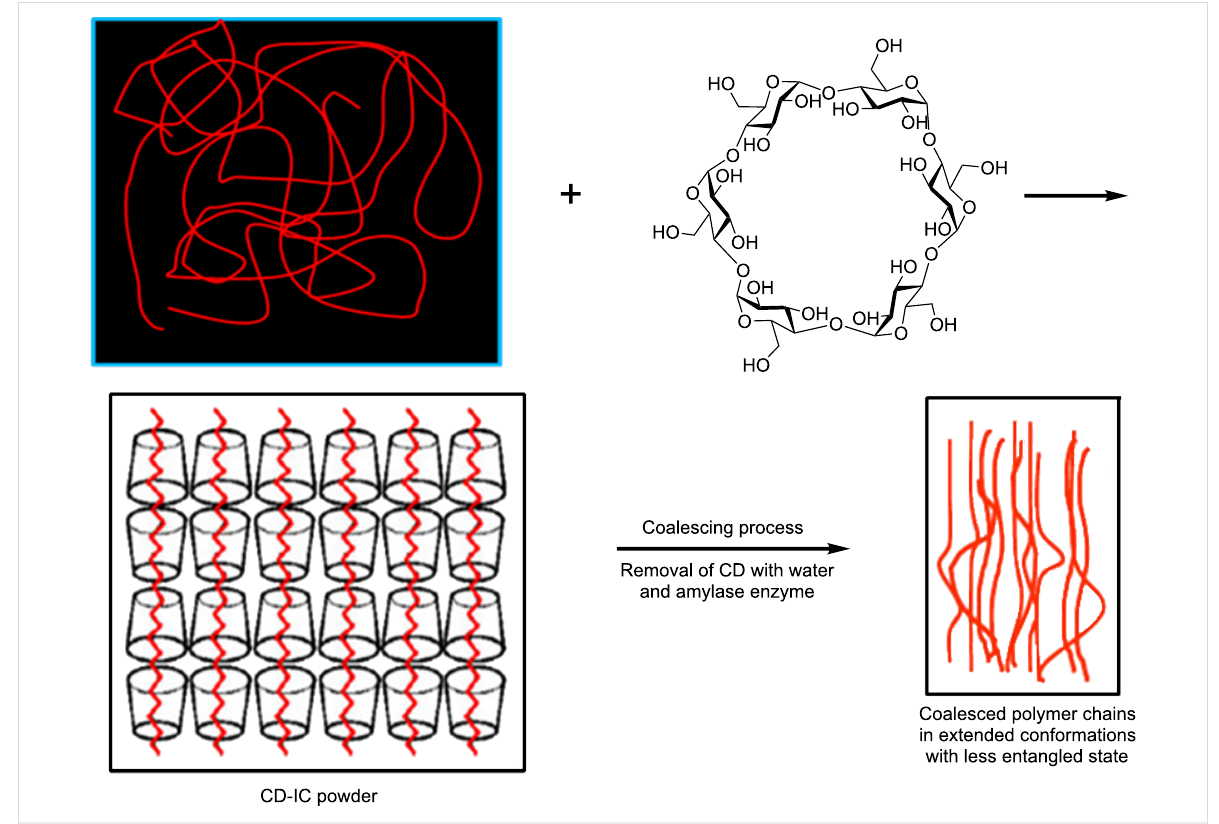
Figure 1: Formation of and coalescence of a polymer sample from its crystalline cyclodextrin inclusion complex